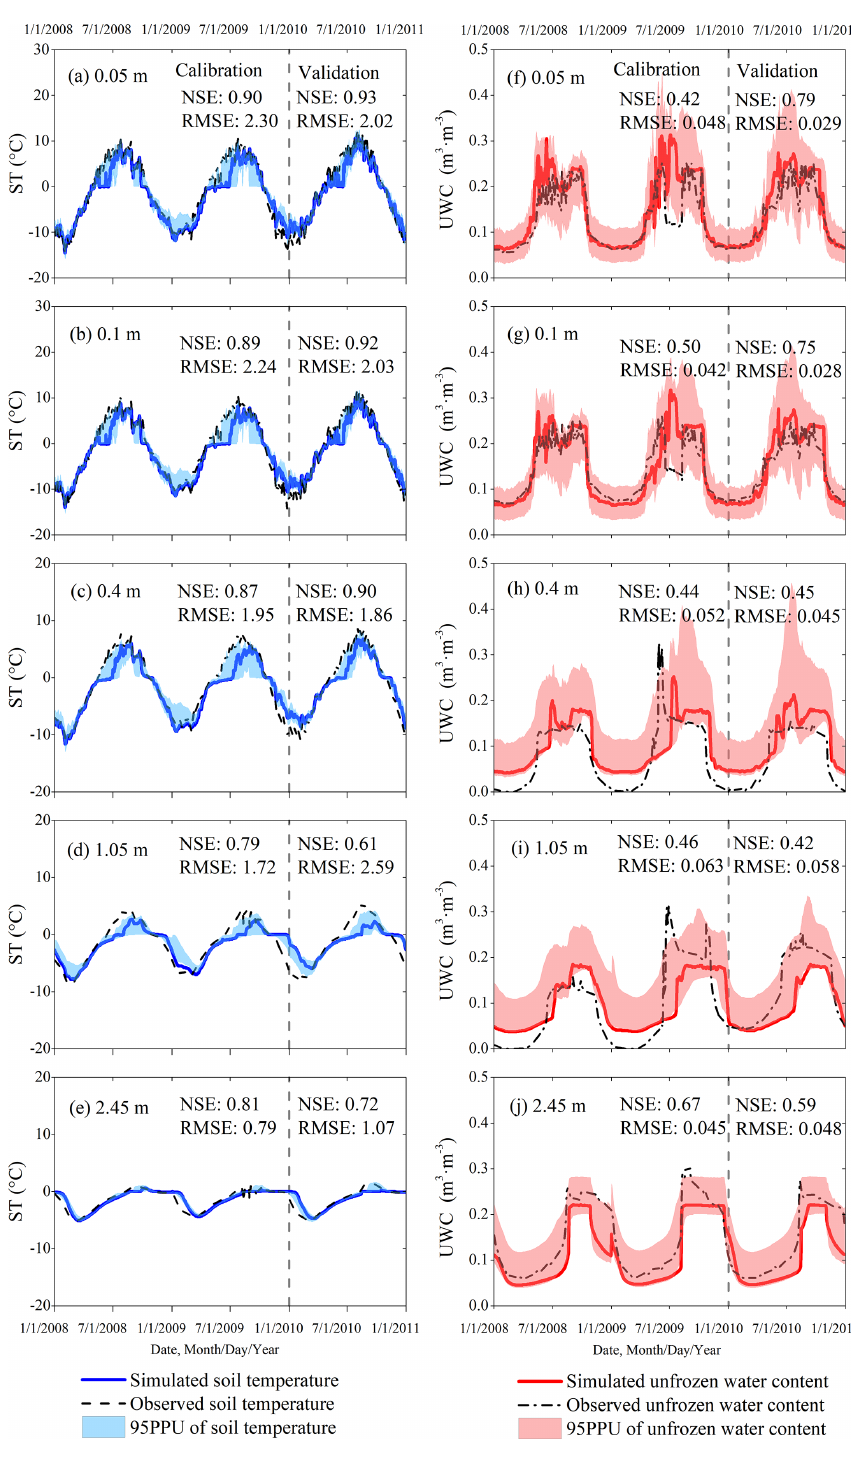
Figure 2. Simulated (solid lines) and observed (dashed lines) daily soil temperature (ST; left panels) and unfrozen water content (UWC; right panels) at 0.05 (a, f) , 0.1 (b, g) , 0.4 (c, h) , 1.05 (d, i) , and 2.45m (e, j) depths at the Tanggula (TGL) site from 1 January 2008 to 31 December 2010. The simulated soil temperatures (solid blue line) and UWCs (solid red line) are the results with the optimal parameter values identified from the 1000 random parameter combinations. NSE: the Nash–Sutcliffe efficiency coefficient; RMSE: root mean square error. The 95PPUs of the model outputs are from all 1000 randomly generated parameter